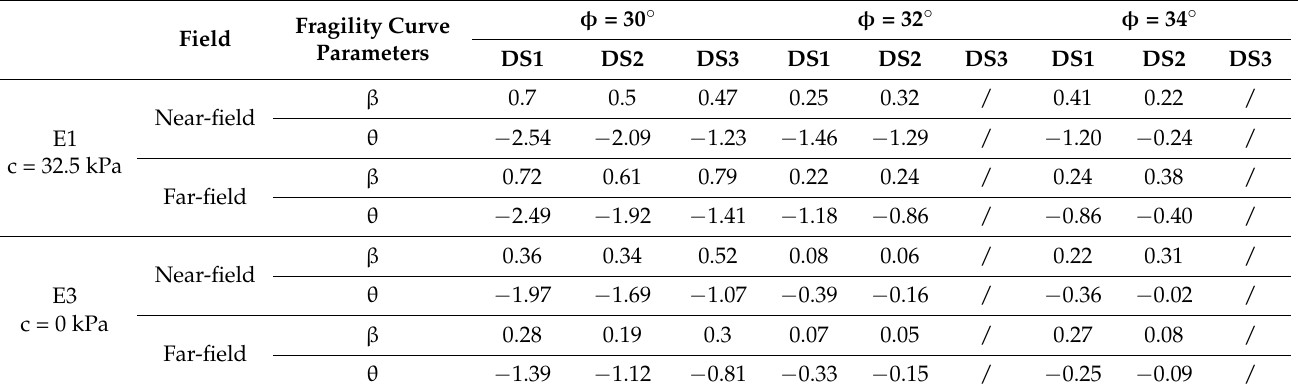
Table 7. Fragility curve parameters considering several friction angles of the soil properties subjected to near-field and far-field earthquake ground